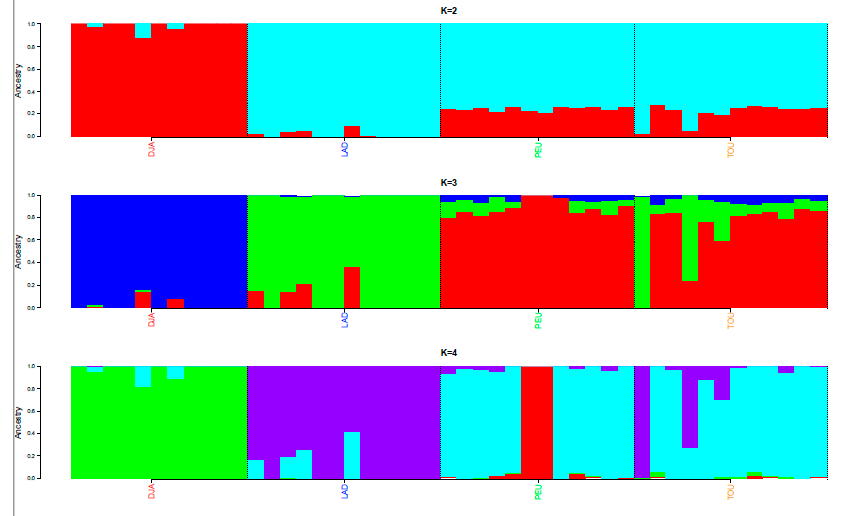
Figure 2. Unsupervised hierarchical clustering of the 47 individuals of the four Senegalese breeds genotyped for 44,321 SNPs (SEN-Set). Results for an inferred number of clusters k varying from 2 to 4 are shown.